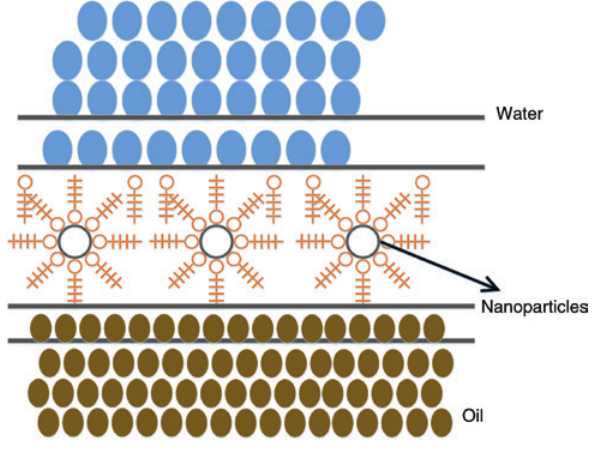
Figure 3: Simplified diagram of the NPs in the interface of oil and water